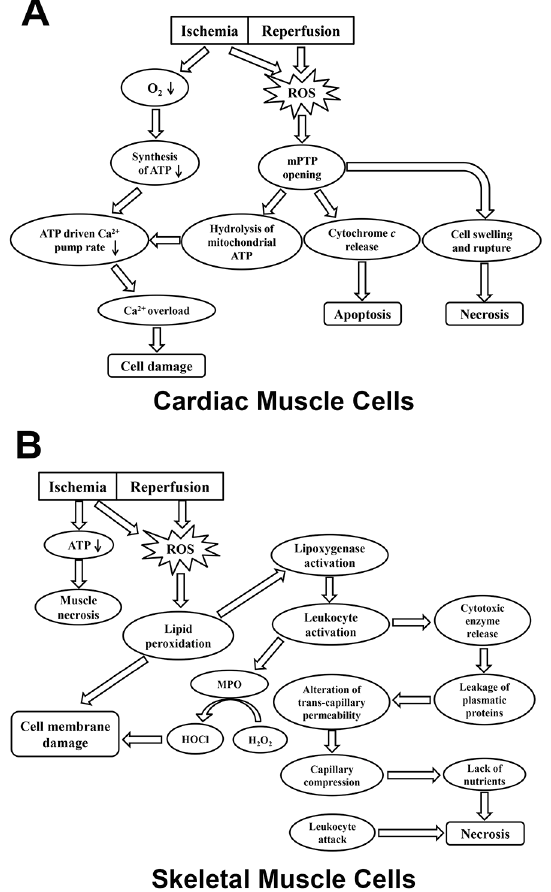
Figure 1. Schematic illustrating ROS-involved mechanisms underlying IR injury in cardiac muscle cells ( A ) and skeletal muscle cells ( B ). Downward arrows indicate decreased levels of parameters. IR, ischemia reperfusion; MPO, myeloperoxidase; mPTP, mitochondrial permeability transition pore; ROS, reactive oxygen species.